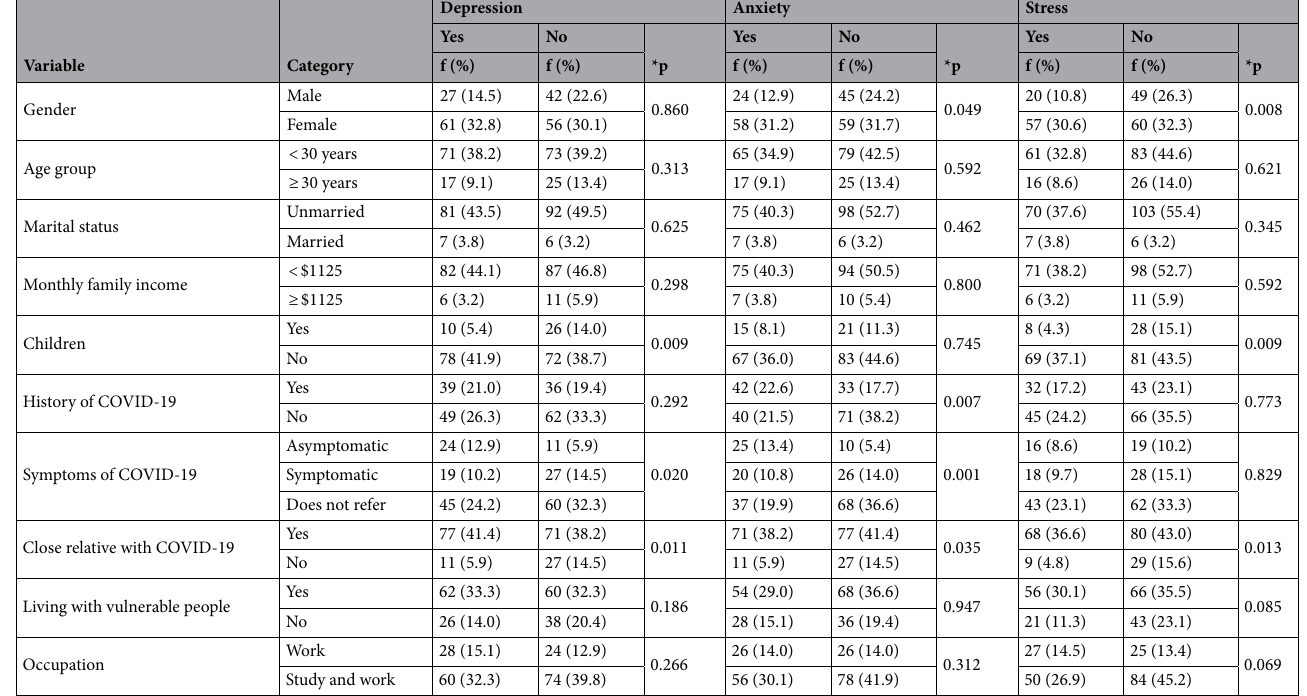
Table 3. Depression, Anxiety and Stress associated with sociodemographic factors of dental students in a Lima population during the second wave of COVID-19. *Based on Pearson’s chi-square, p < 0.05 (significant